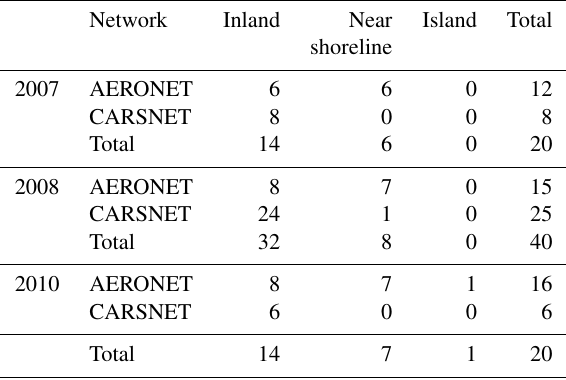
Table 2. Selected ground-based sites in